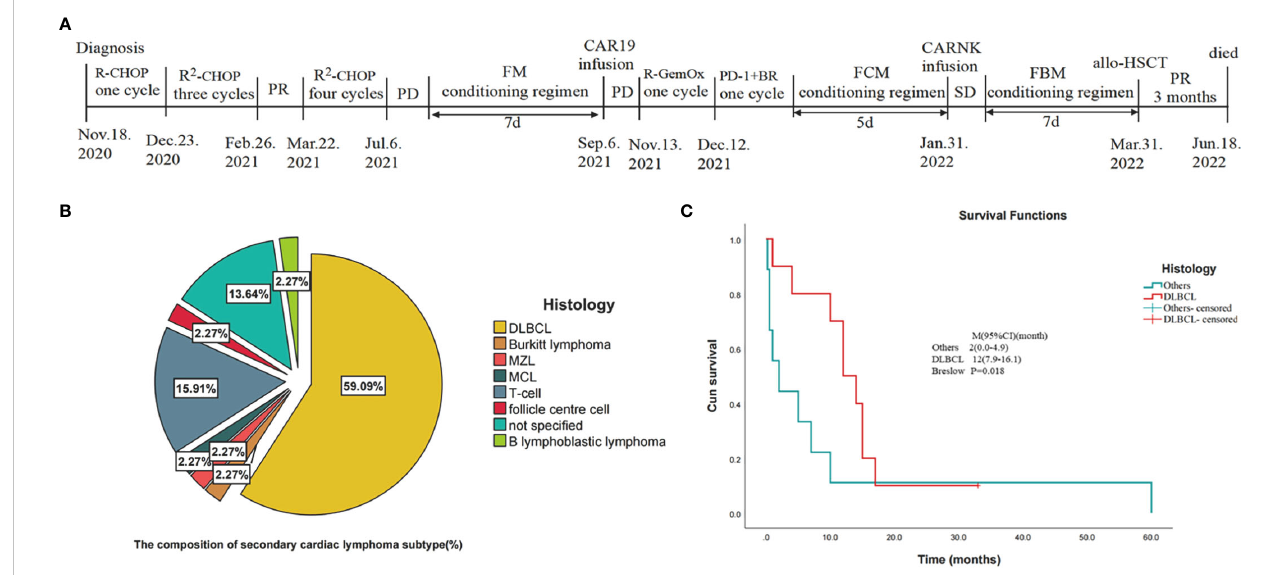
FIGURE 3 Statistical analysis of the data in the literature review (10 – 48) and the timeline of disease status and corresponding treatment regimens of our patient. (A) Timeline of disease status and corresponding treatment regimens. (B) Pie chart of tissue type composition of secondary cardiac lymphoma. (DLBCL, diffuse large B-cell lymphoma; MZL, marginal zone lymphoma; MCL, mantle cell lymphoma; T-cell: T cell lymphoma). (C) Kaplan-Meier survival curves for secondary cardiac lymphomas comparing DLBCL with other cancers included in the statistics. (CI, con fi dence